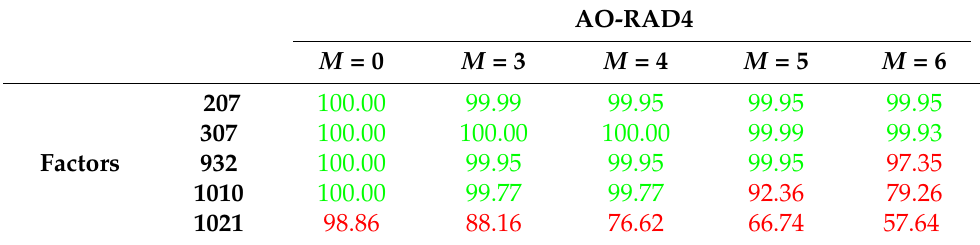
Table 1. Cross signature scale factor (CSF) for different parameter M values: combinations that satisfy tolerance for A-weighting filtering are marked in green, otherwise in